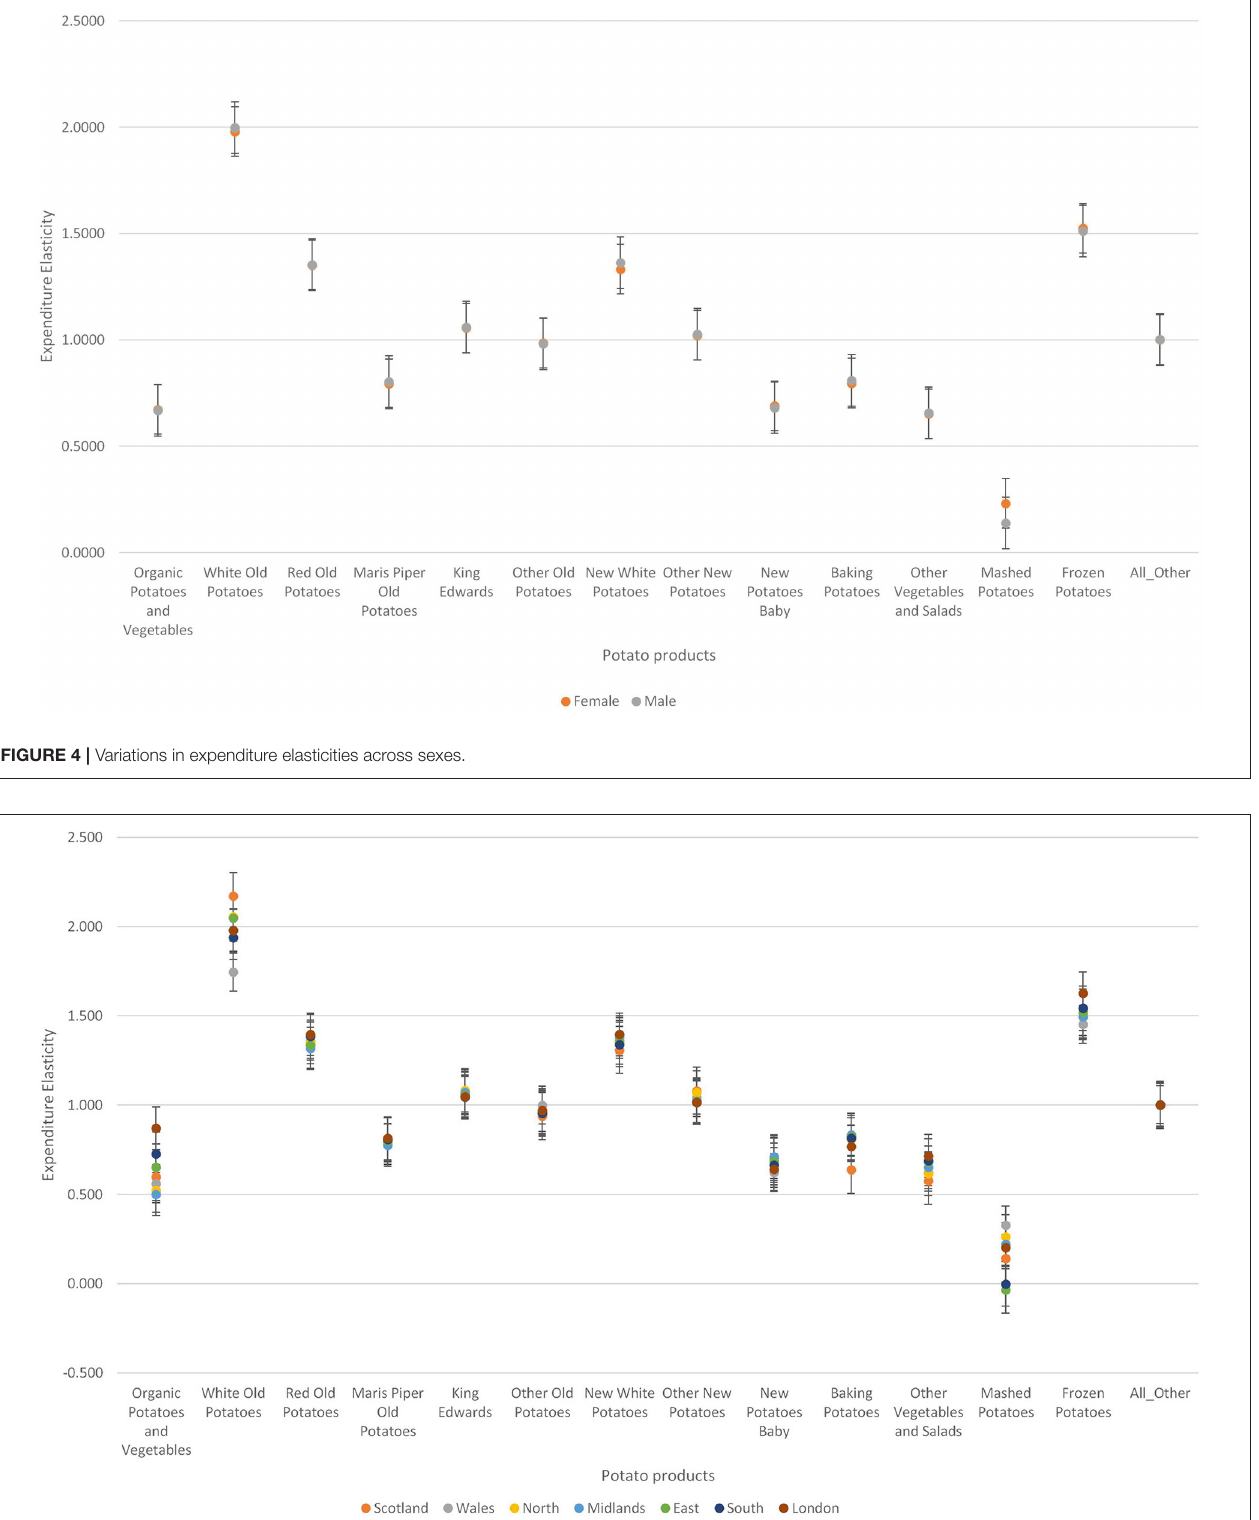
FIGURE 5 | Variations in expenditure elasticities across regions in the United Kingdom.